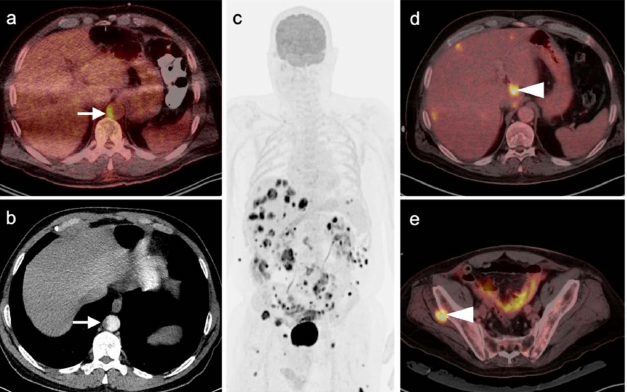
Figure 18. Angiosarcoma of the aorta with downstream hematogenous metastases. ( a ) Axial FDG PET-CT demonstrates a crescentic hypermetabolic lesion in the lower thoracic aorta (white arrow). ( b ) Concurrent axial contrast-enhanced CT shows a crescentic filling defect in the lower thoracic aorta (white arrow). ( c ) Three months later, following radiation of the aortic tumor and an initial thoracic vertebral metastases (not shown) an FDG PET-CT MIP shows the development of numerous metastatic deposits, all “downstream” from the primary aortic lesion. ( d ) Axial FDG PET-CT image of the upper abdomen shows liver metastases (white arrow). ( e ) Axial FDG PET-CT image of the pelvis shows a hypermetabolic lesion in the right gluteus minimus invading the iliac bone (white arrowhead).